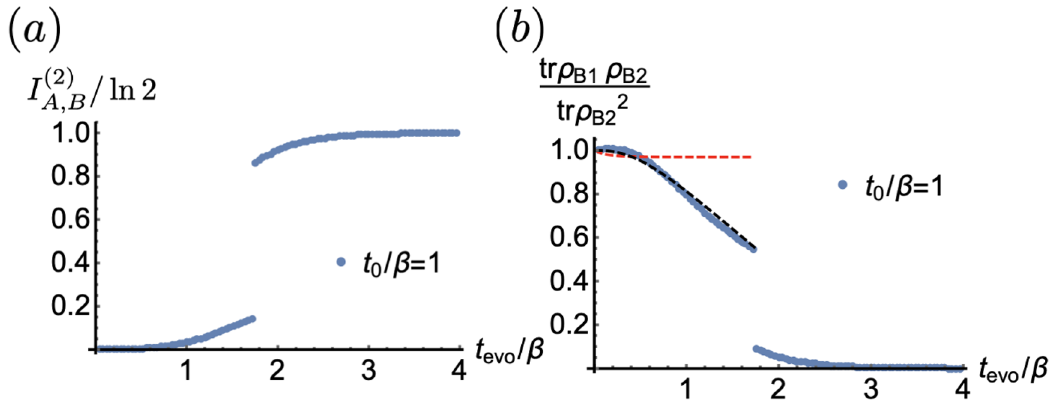
Figure 9. We illustrate how the overlap tr( (cid:26) B; 1 ( t ) (cid:26) B; 2 ( t )) is related to our saddle point solution G , to the leading order in N .